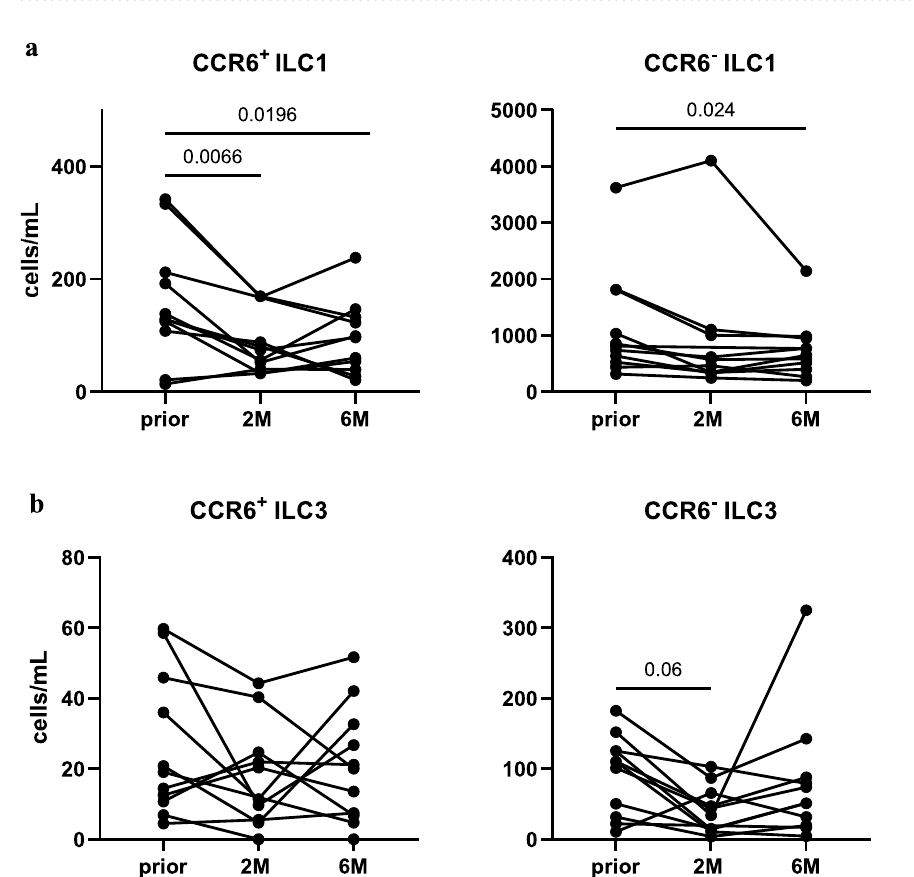
Figure 5. CCR6+ ILC3 are exempted from CladT-induced reductions in helper ILC. ( a ) CCR6+/− ILC1, and ( b ) CCR6+/− ILC3 as cells/mL in MS patients at baseline ( prior , n = 11), and 2 ( 2M , n = 10), and 6 months ( 6M , n = 11) following administration of CladT. A linear mixed-effects model was calculated to compare between MS patients before and after treatment. 4999 permutations were then run to calculate p-values. Holm’s corrections were used for multiple comparisons which were performed to compare the different timepoints ( prior , 2M & 6M ). p-values of p < 0.1 are indicated on the